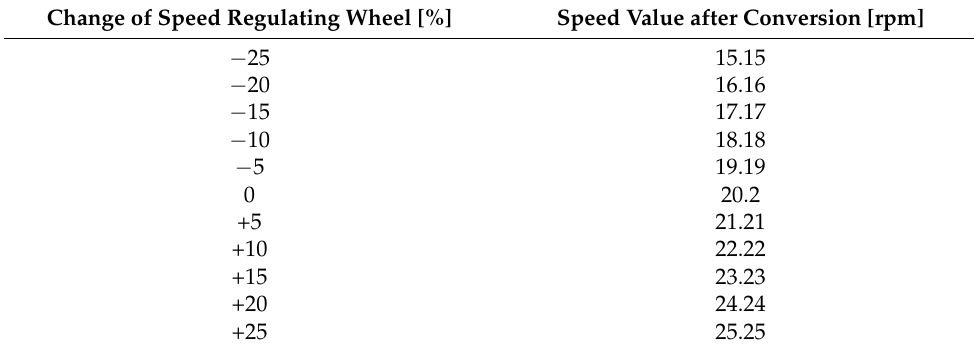
Table 4. Different cutting